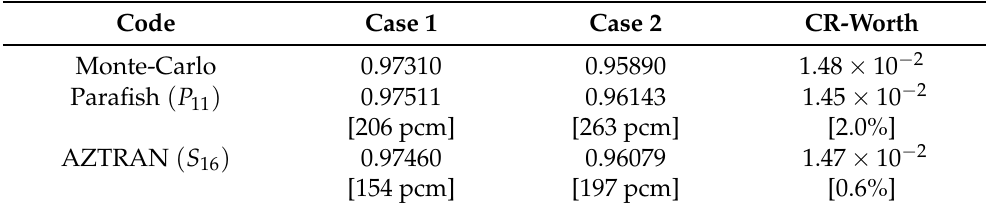
Table 2. Comparison of k ef f and control rod worth for Small FBR